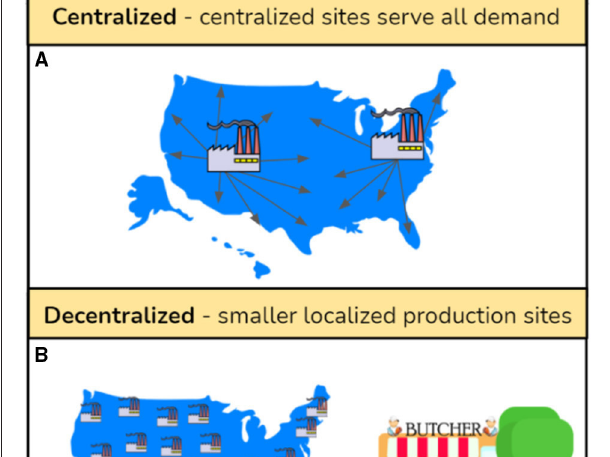
solutions for energy efficiency and clean, secure energy